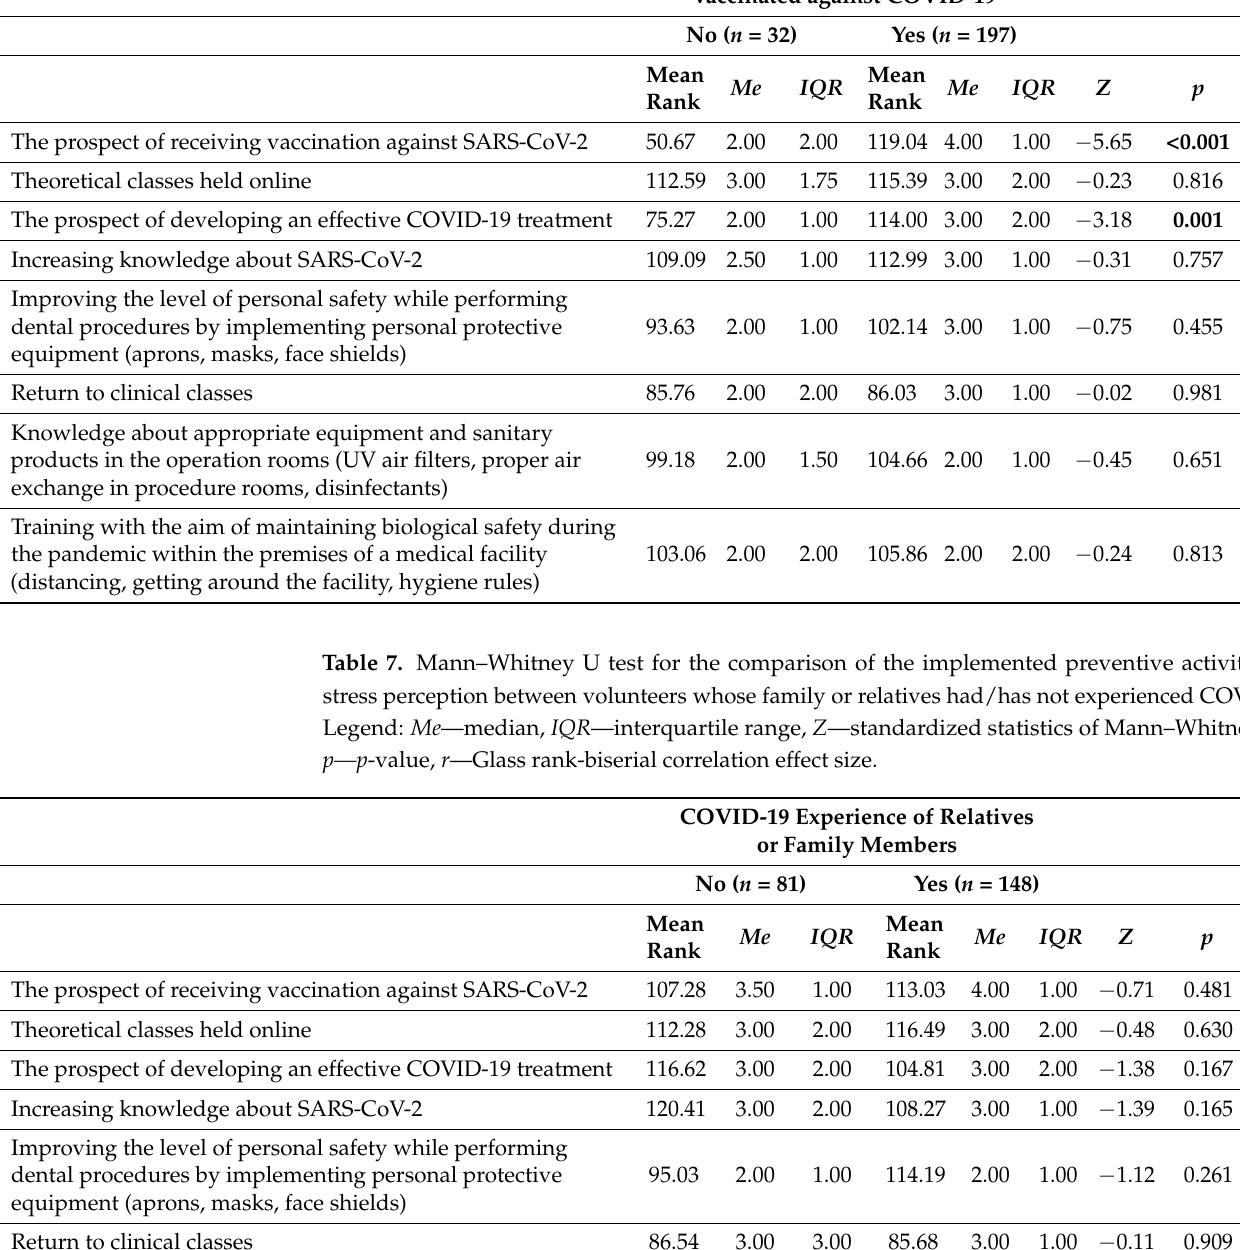
Table 6. Mann–Whitney U test for the comparison of the implemented preventive activities on stress perception between volunteers who were vaccinated or were not vaccinated against COVID-19.